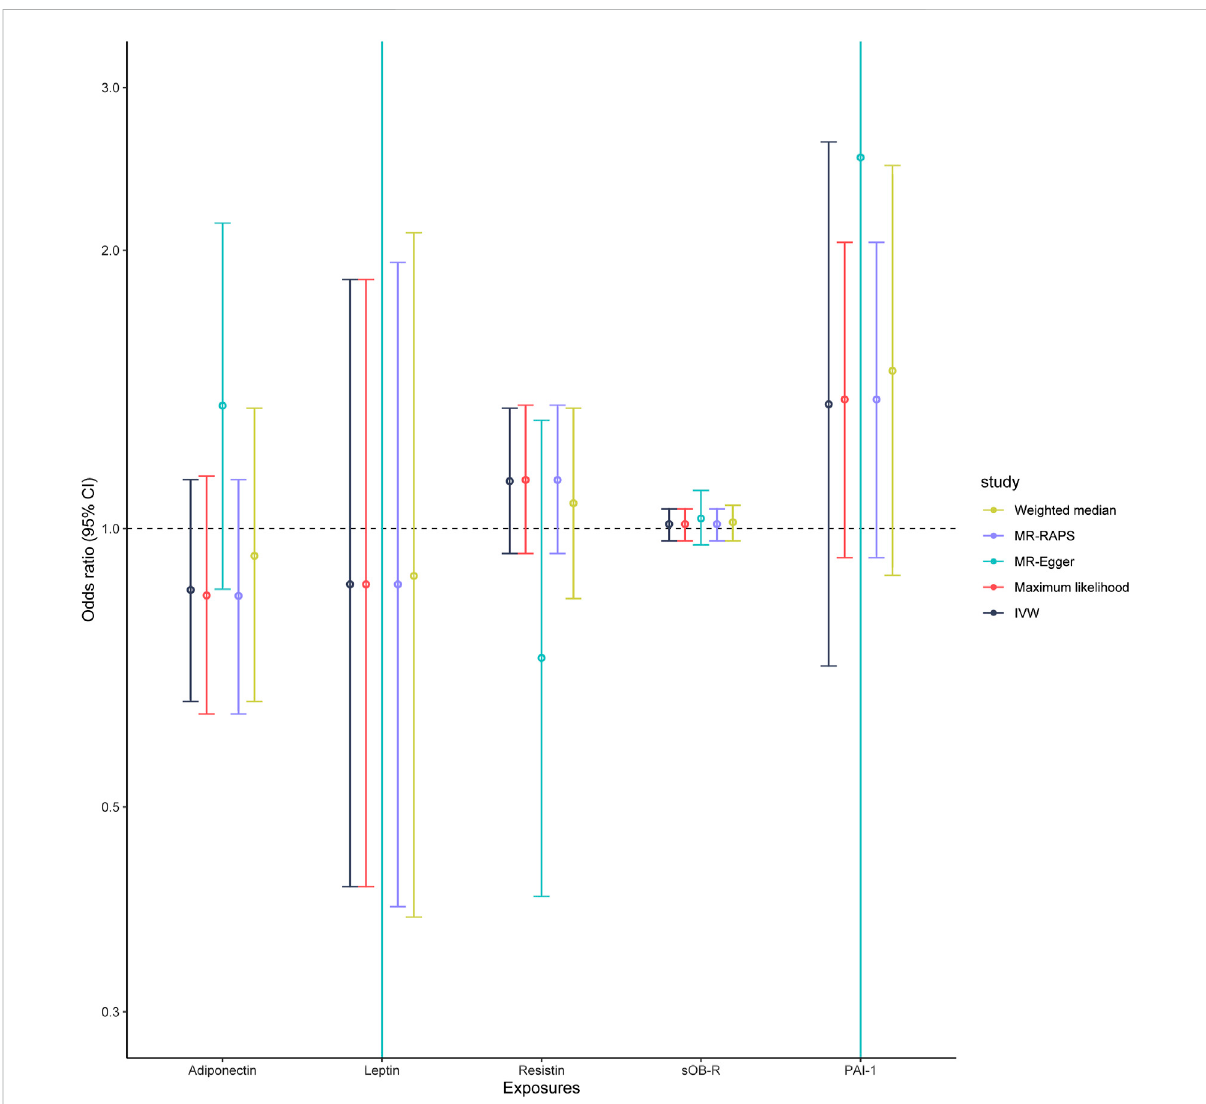
FIGURE 2 Associations of genetically predicted circulating adipokine levels with PET according to different Mendelian randomization methods. Abbreviations: IVW, inverse-variance weighted; MR-Egger, Mendelian randomization Egger; MR-RAPS, Mendelian randomization robust adjusted pro fi le score; OR, odds ratio; 95% CI, 95% con fi dence